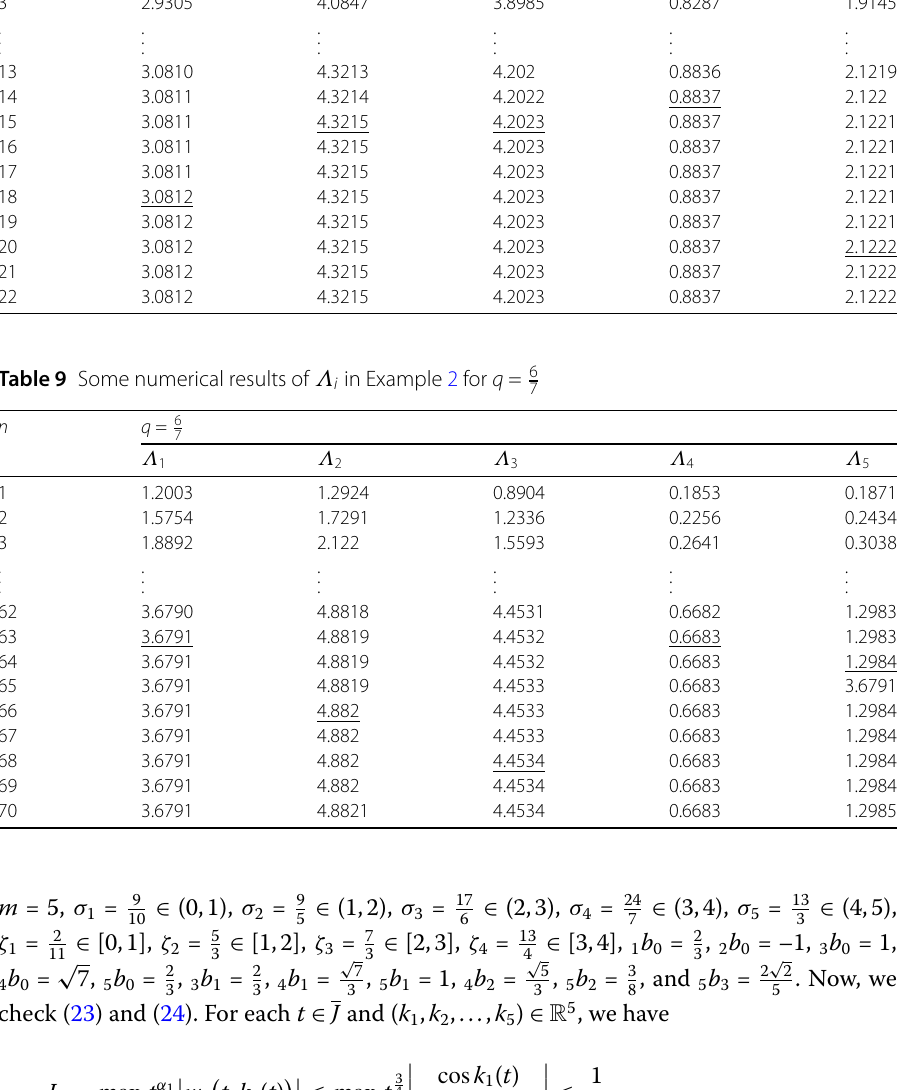
Table 8 Some numerical results of Λ i in Example 2 for q = 1